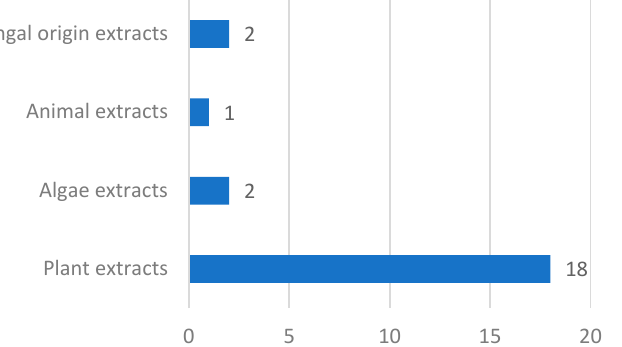
Figure 1. Distribution of 23 extracts authorized to be used in food supplements according with Novel Food Regulation.